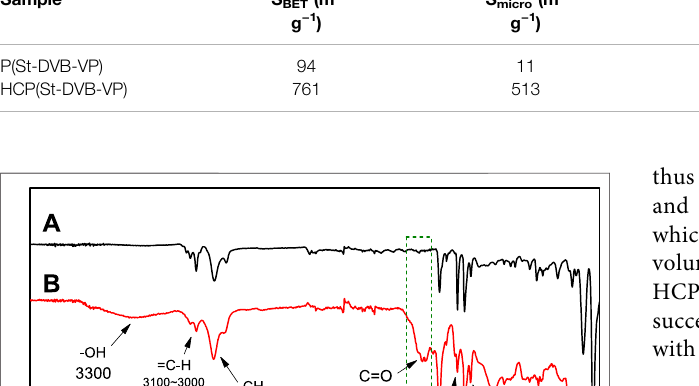
TABLE 1 | Textural properties of P(St-DVB-VP) and HCP(St-DVB-VP) samples. Sample